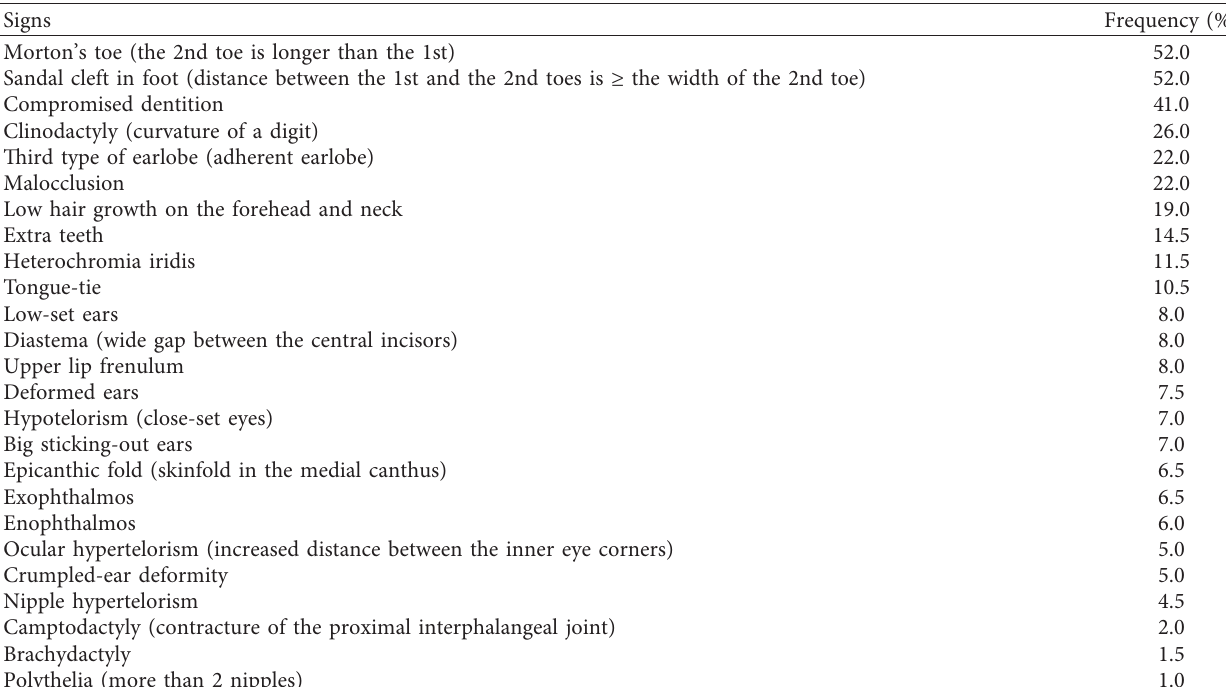
Table 1: Developmental abnormalities corresponding to CTD-related cosmetic syndrome